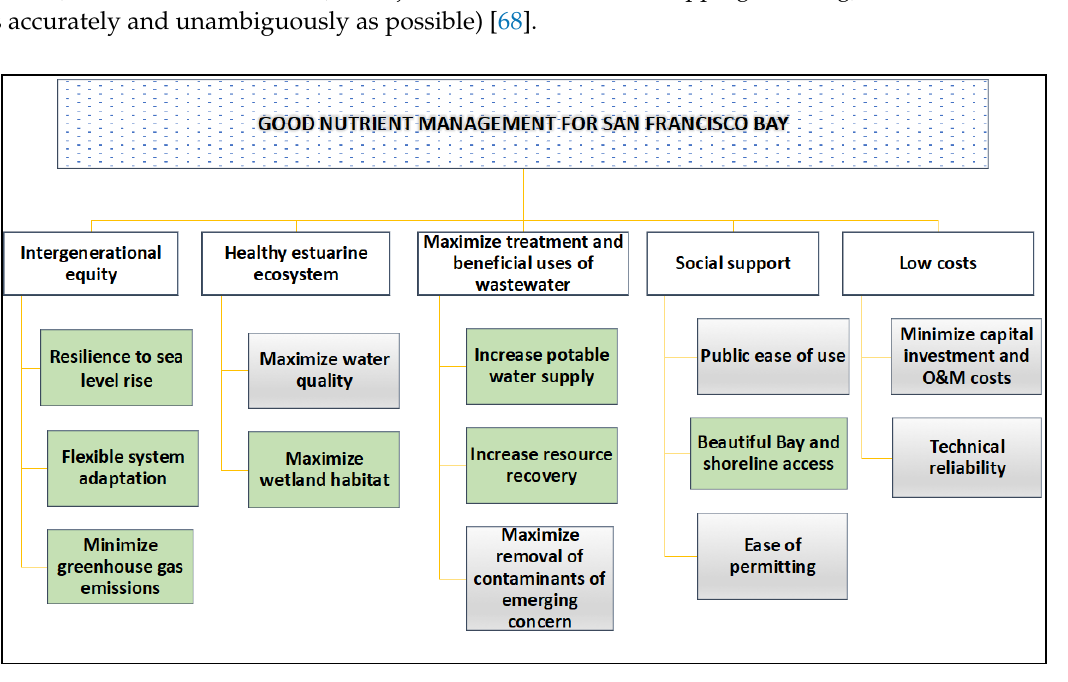
Figure 1. Objectives hierarchy for good nutrient management for San Francisco Bay were derived from interviews with 32 stakeholders. Objectives are color-coded by overarching categories (white background) Objectives that are characteristic of traditional wastewater infrastructure upgrades have a grey background and objectives that are indicative of a new paradigm for multi-benefit wastewater treatment have a green background. Reasons for the categorization are explained in the text. Descriptions of the objectives (in the order shown in Figure 1) are given below. Supporting